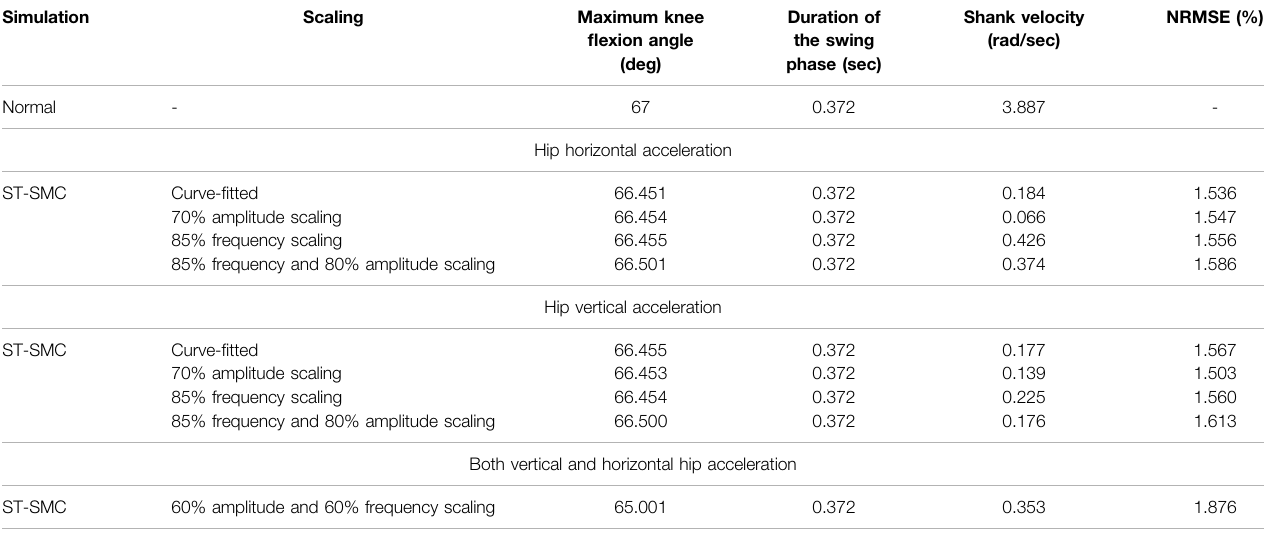
TABLE 3 | Robustness evaluation.